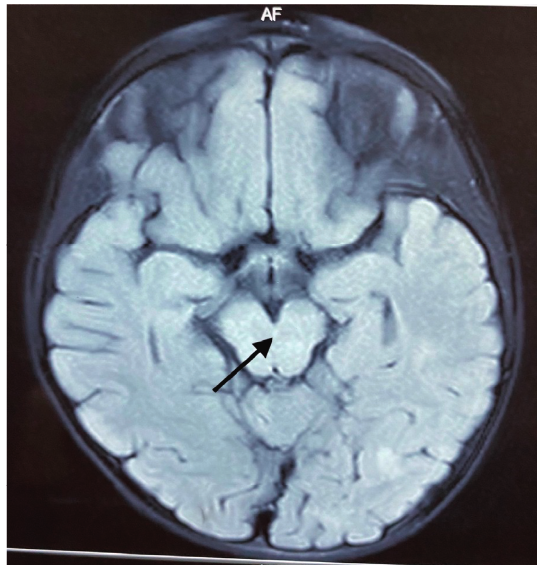
Figure 2: MRI brain performed three months after treatment, showing marked improvement in signal intensity changes in the